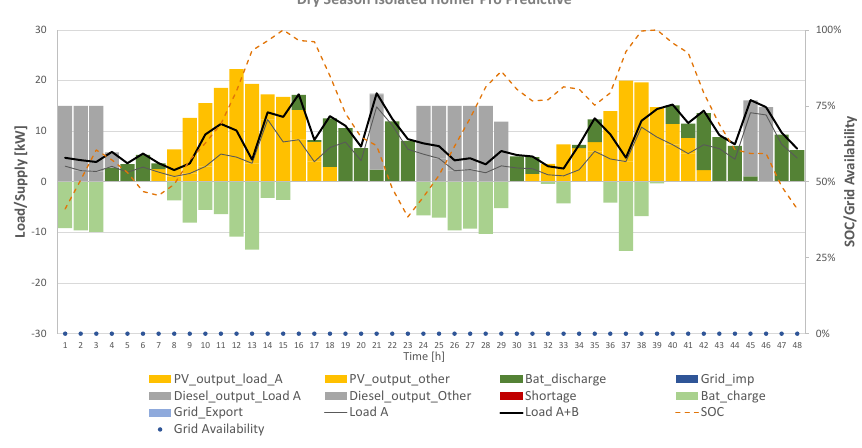
Figure 20. HOMER Pro’s predictive strategy for dry season off-grid